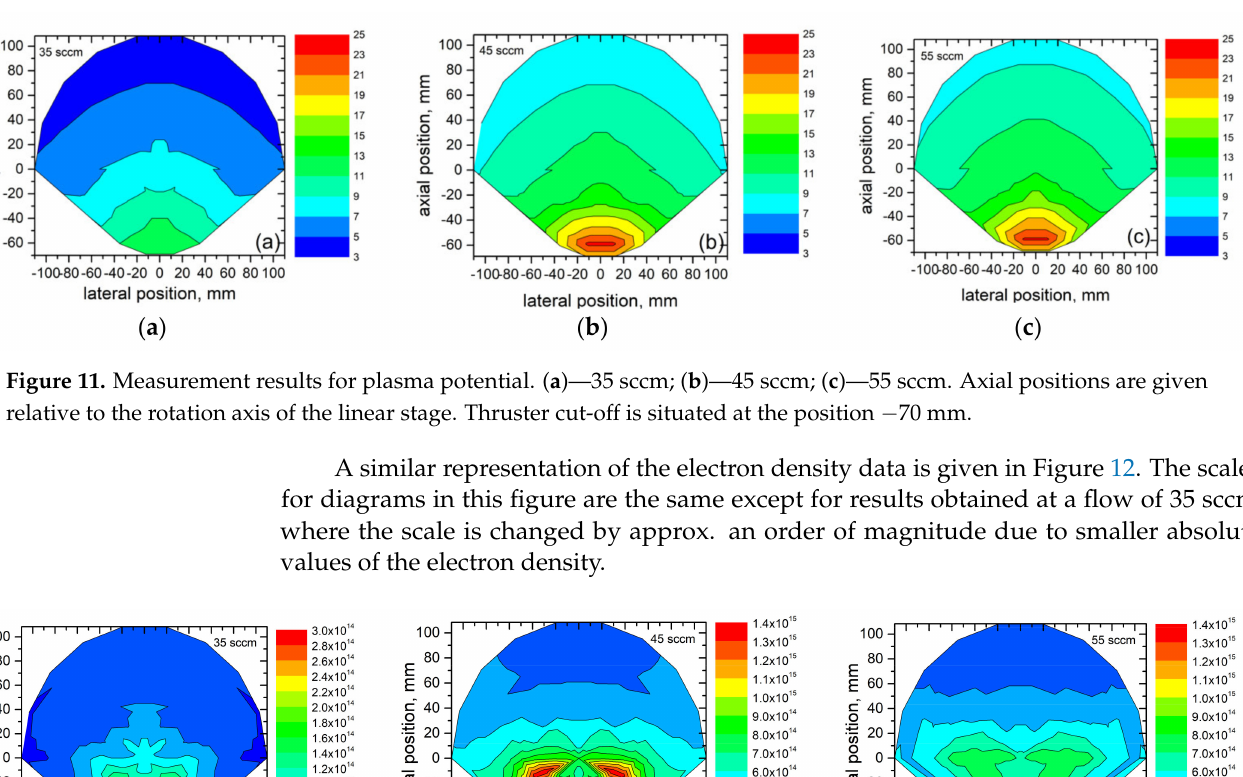
Figure 10. Measurement results for plasma potential at 35 sccm propellant flow; ( a )—raw data; ( b )—symmetrized. Axial positions are given relative to the rotation axis of the linear stage. Thruster front is situated at the position − 70 mm.